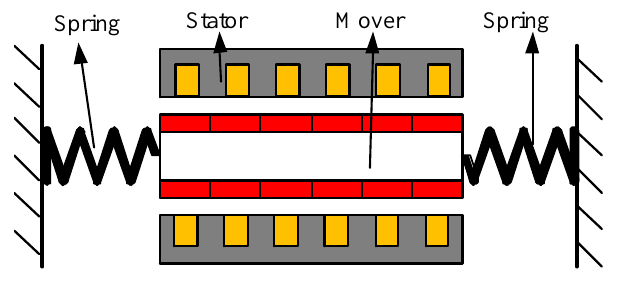
Figure 2. PMLOSM diagram.